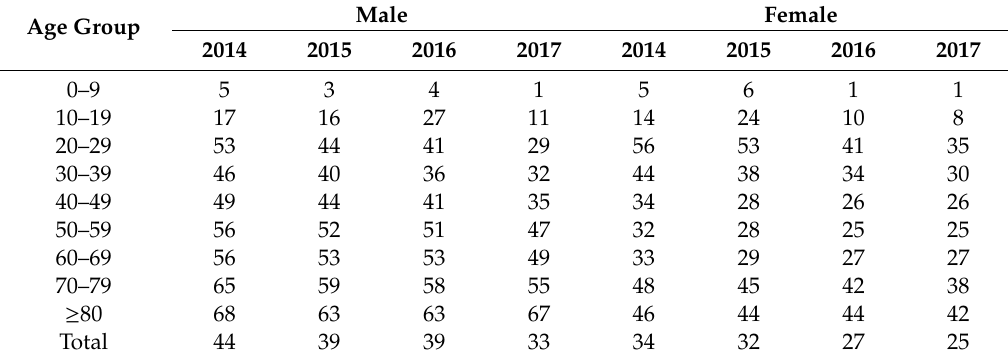
Table 2. Years lived with disability due to tuberculosis per 100,000 population in Korea by sex and age, 2014–2017. Age